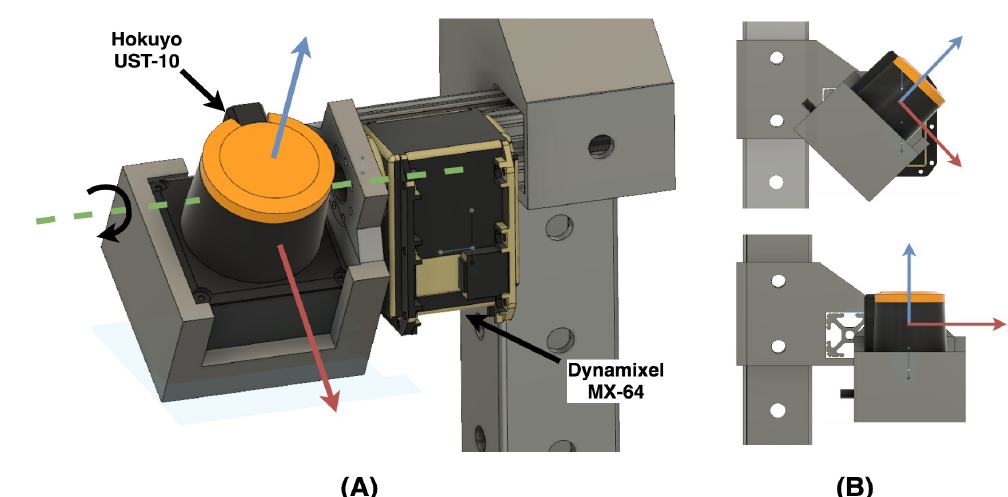
Figure 10. Actuated LiDAR setup. ( A ) A 3-D perspective view and ( B ) a 2-D side view of an actuated LiDAR.